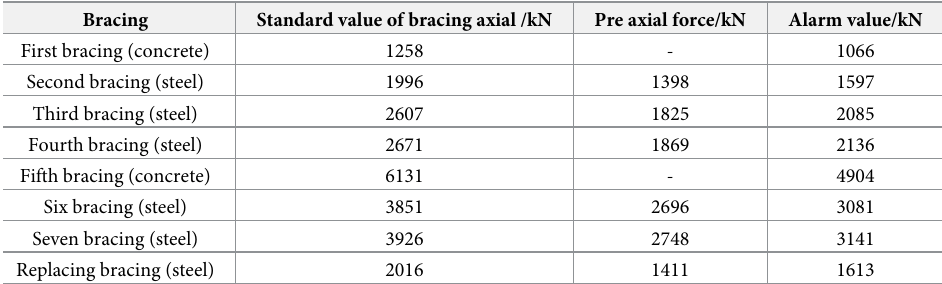
Table 1. Standard bracing axial force values of the main envelope.